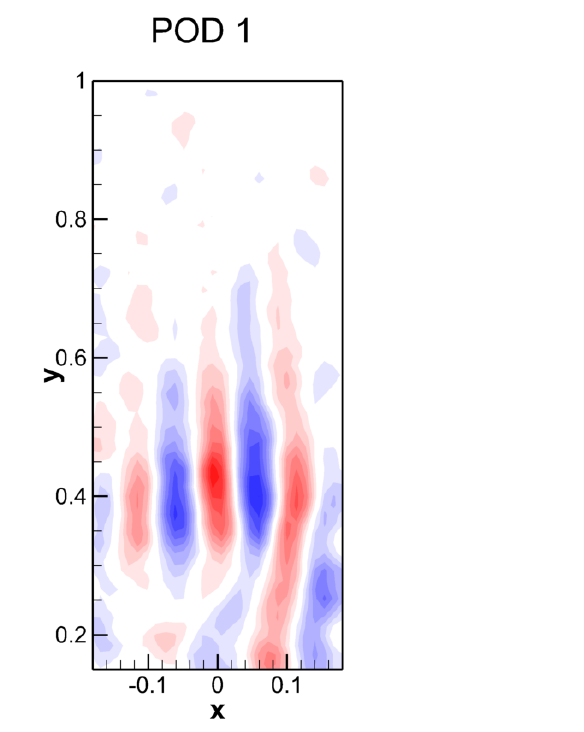
Fig. 16. Vorticity POD mode No. 1, 1.05%